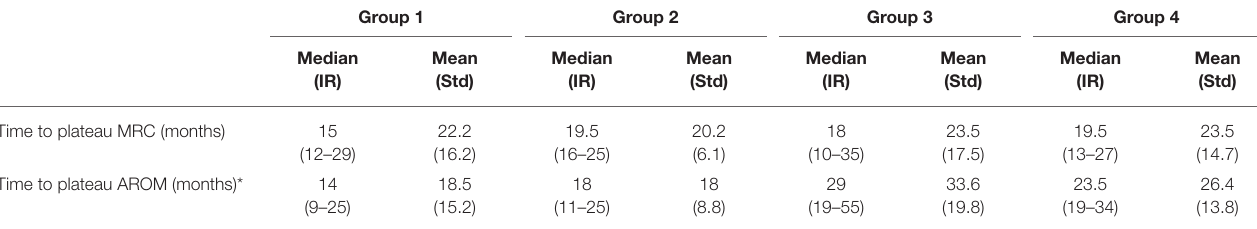
TABLE 5 | Post-operative shoulder abduction assessment